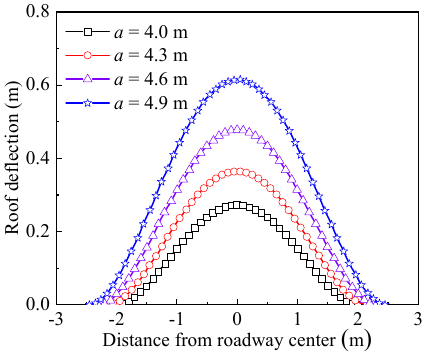
Figure 8. Relationship between composite roof deflection and roadway width.